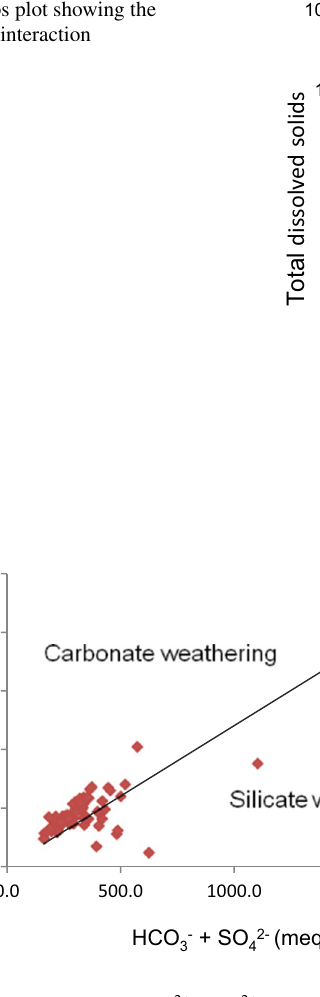
Fig. 5 Scatter plot between Ca 2+ + Mg 2+ and HCO 3− + SO 42− ionic concentrations of the groundwater